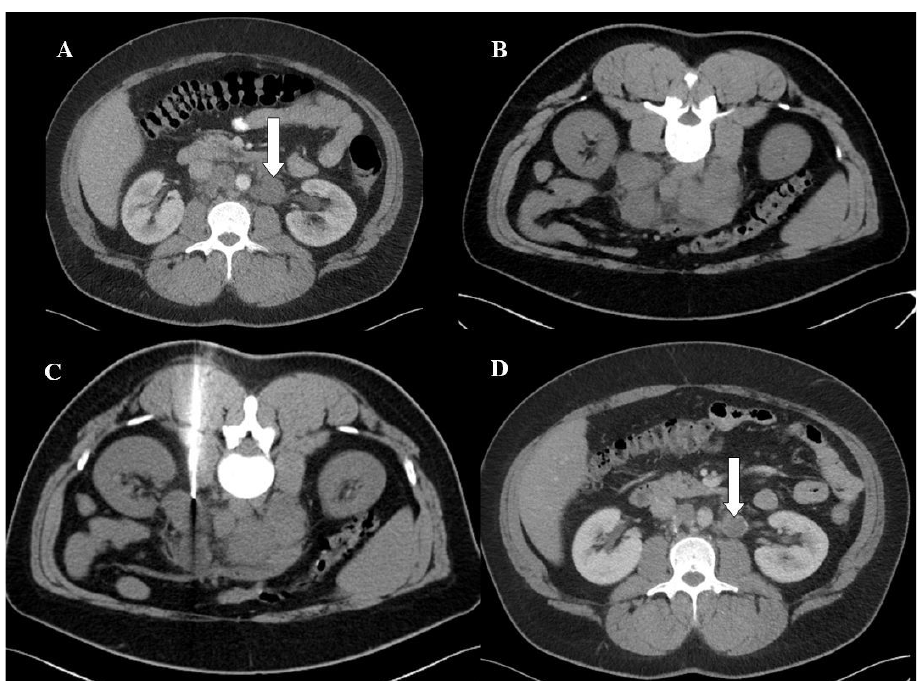
Fig. 4. The false negative result. Hypovascular lymph nodes in the left paraaortal region on contrast medium enhanced CT examination (A, arrow). Preprocedural CT examination (B, patient in prone position) and inserting of the biopsy needle (C). The histological result was completely necrotic tis- sue. Surgical excision biopsy was performed and germinal cell tumor was verified. Targeted systemic treatment was indicated; follow-up CT examination 4 months after establishment of diagnosis was performed with partial regression verification (D,